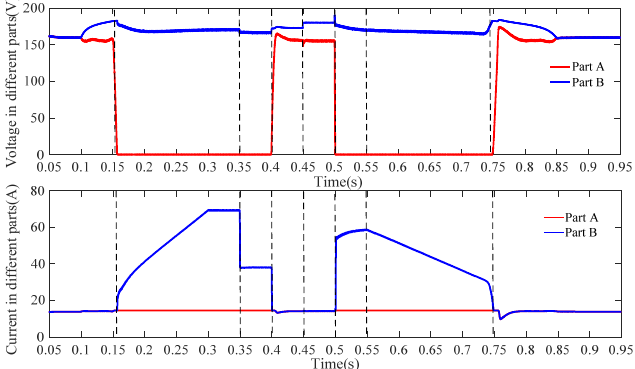
Figure 12. Output current and voltage in different parts of the PV array.